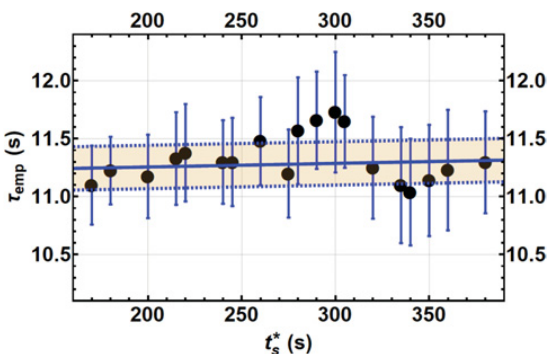
Figure 1. The emptying time constant of UCNs as a function of micro-timer storage time. The solid line indicates a linear fit. The dashed lines show the case for a ± 1 σ deviation of the constant